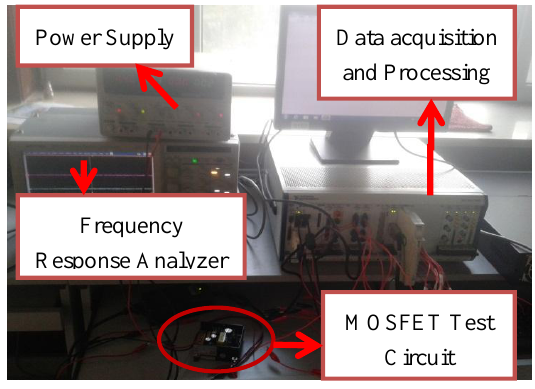
Figure 3. Experimental setup. Figure 4. Experimental